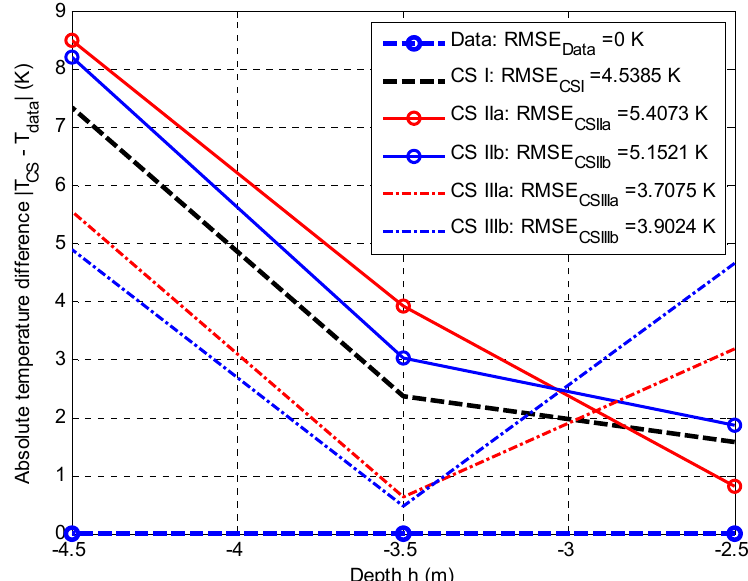
Figure 9. All case studies: Comparison of the results for the thermal profile to measured data (reference